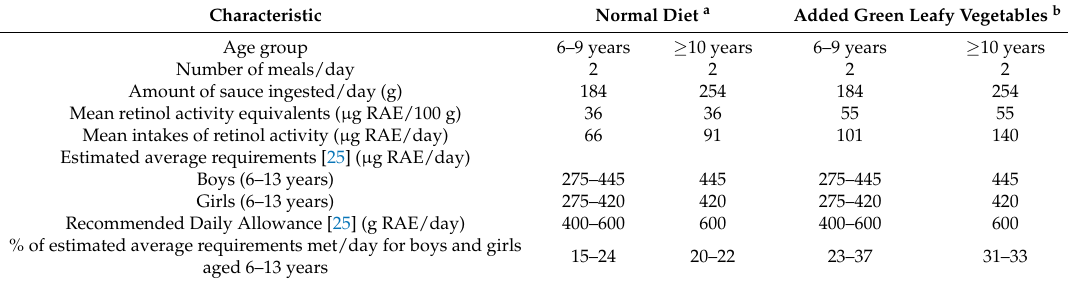
Table 3. Retinol activity equivalents (RAE) from sauce intake in Burkinabe children and coverage of the child’s vitamin A requirements in relationship to the Estimated Average Requirements and the Recommended Daily